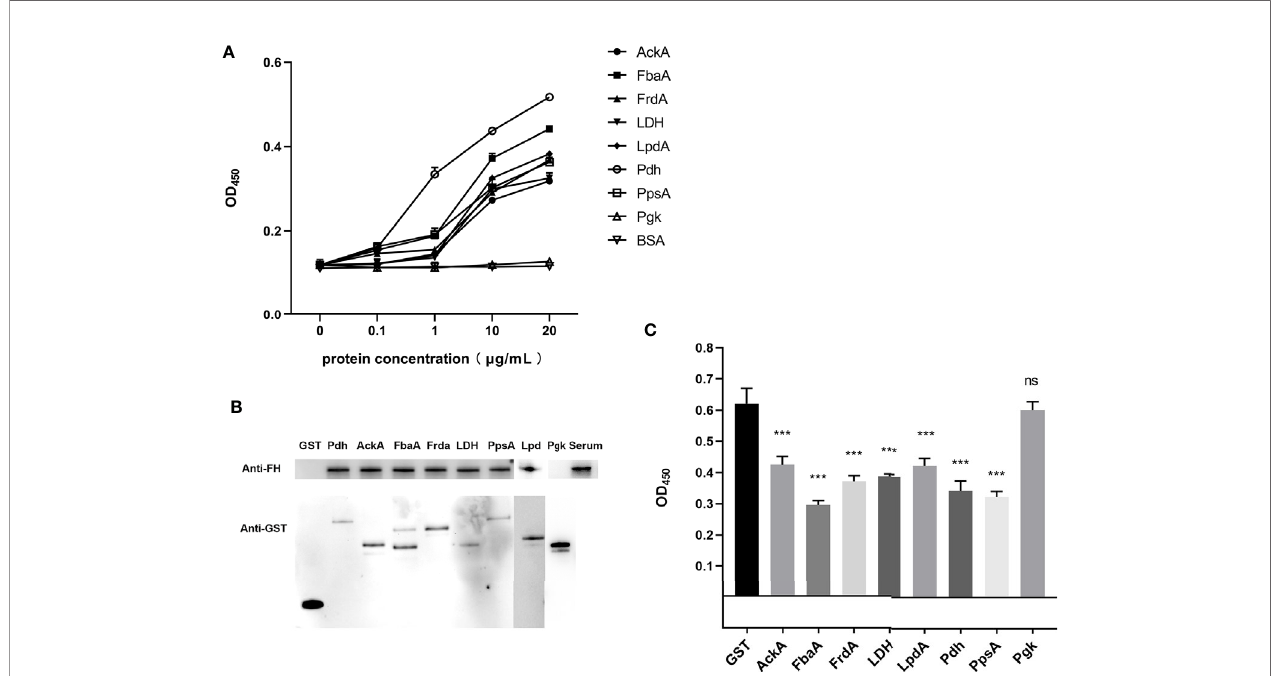
FIGURE 3 | Identi fi cation of the FH-binding ability of CMEs in ExPEC. (A) ELISA plates were coated with the indicated concentrations of His-tag recombinant proteins or BSA, and then incubated with human serum. The bound FH was detected. Data are expressed as the mean ± SD of three independent experiments. The statistical signi fi cance was determined using the unpaired t test (*** p < 0.001). (B) GST pull-down assay was carried out to con fi rm the interaction between FH and CMEs. The upper part of the panel B shows the FH-binding ability of the GST-fusion protein, and the lower part of panel B shows the results of the detection of the GST-fusion proteins. (C) FH binding inhibition assay of magnetic beads coupled with recombinant proteins. Magnetic beads coupled with GST-fusion proteins or GST protein were co-incubated with ExPEC in 10% human serum solution. The ExPEC FH-binding levels were detected by ELISA. The statistical signi fi cance was determined using the unpaired t test (*** p < 0.001). Data are expressed as the mean ± SEM of three independent